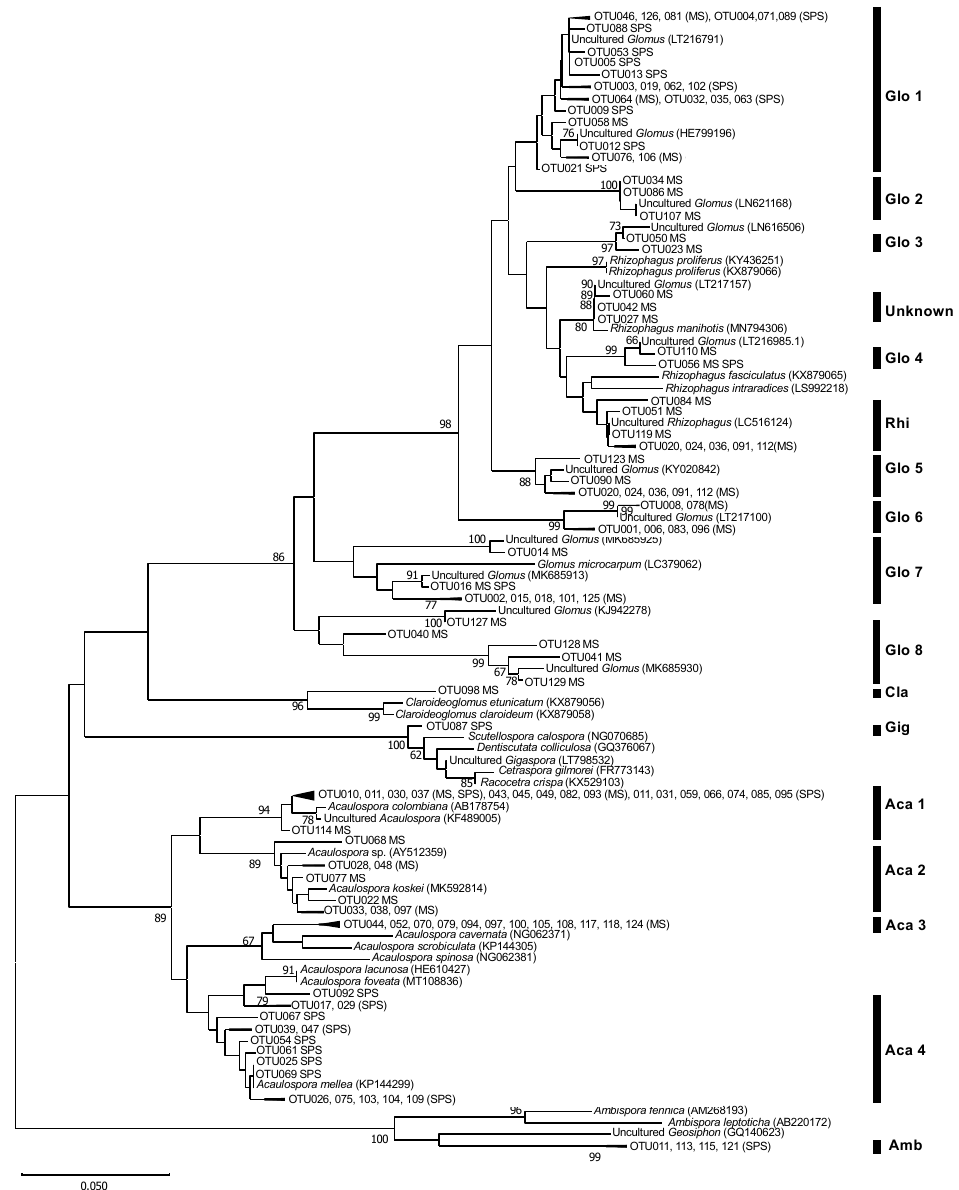
Figure 3. A neighbor-joining tree of partial SSU rDNA sequences obtained from the roots of the sago palm. Bootstrap values (only values > 60 are shown) were estimated from 1000 replicates. Reference sequences were incorporated from the NCBI Genbank. Table 2. The number of operational taxonomic units (OTUs) and relative abundance (RA) in each clade.